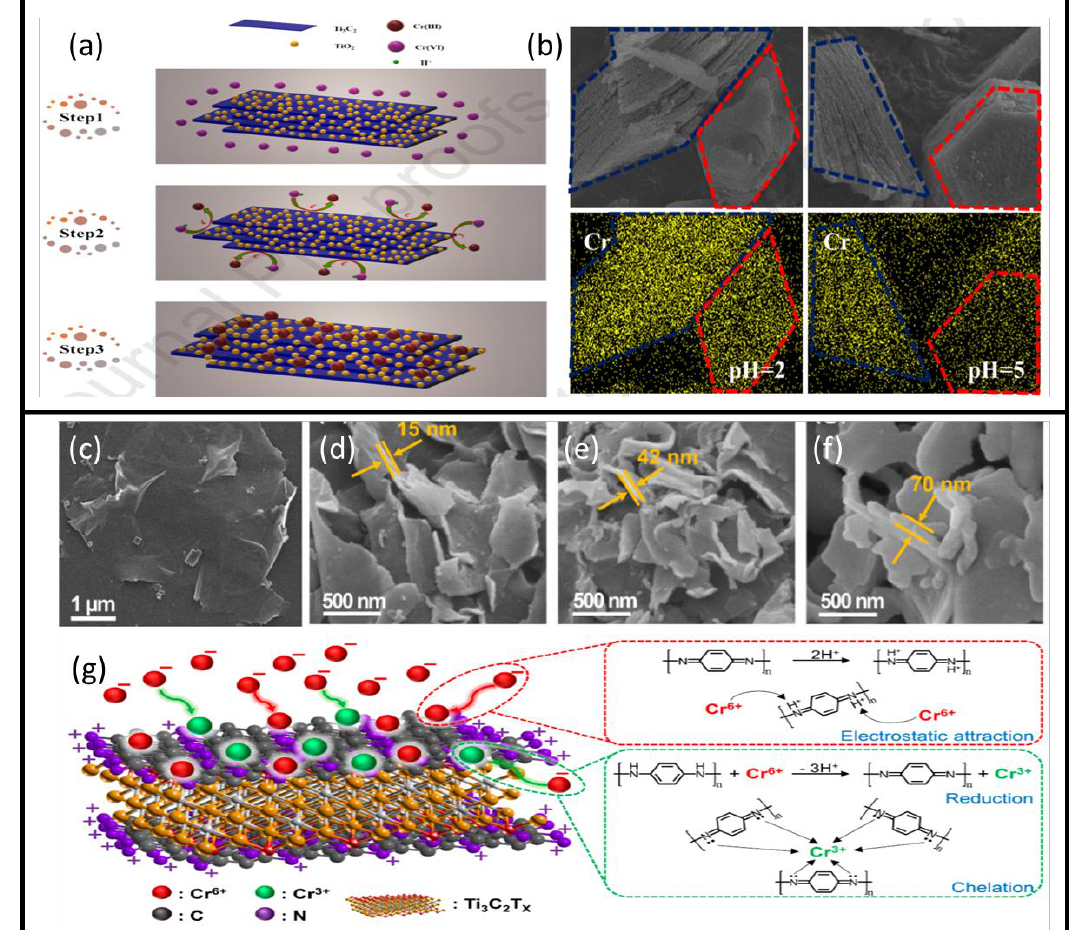
Figure 7. ( a ) Cr(VI) reduction and removal mechanism using Ti 3 C 2 /TiO 2 composite. ( b ) SEM element mapping of the Ti 3 C 2 /TiO 2 composites before and after chromium adsorption at two different pH levels: 2 and 5. Adapted and reproduced with permission from [56] Copyright 2020 Elsevier. SEM images of ( c ) Ti 3 C 2 T x, ( d ) Ti 3 C 2 T x /PmPD-2/1, ( e ) Ti 3 C 2 T x /PmPD-5/1, and ( f ) Ti 3 C 2 T x /PmPD-10/1, and ( g )